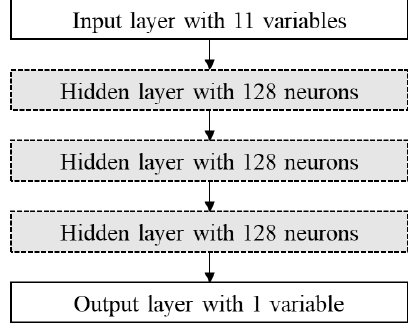
Figure 4. Network architecture chosen for the analysis. Total parameters to be trained is